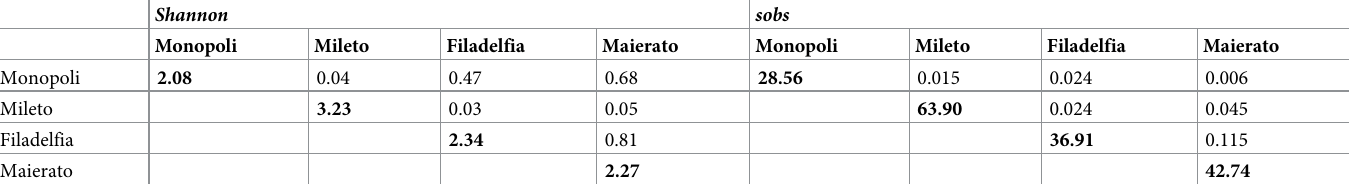
Table 2. Comparison of the alpha diversity of the fungal communities associated to olive drupes in the four investigated localities (Monopoli, Mileto, Filadelfia, and Maierato) according to Shannon and observed species ( sobs ) indexes. P values of the pair-wise comparisons were determined using student-t-test and 999 Monte Carlo permutations. Both Shannon and Sobs Mean values are reported in bold for each investigated